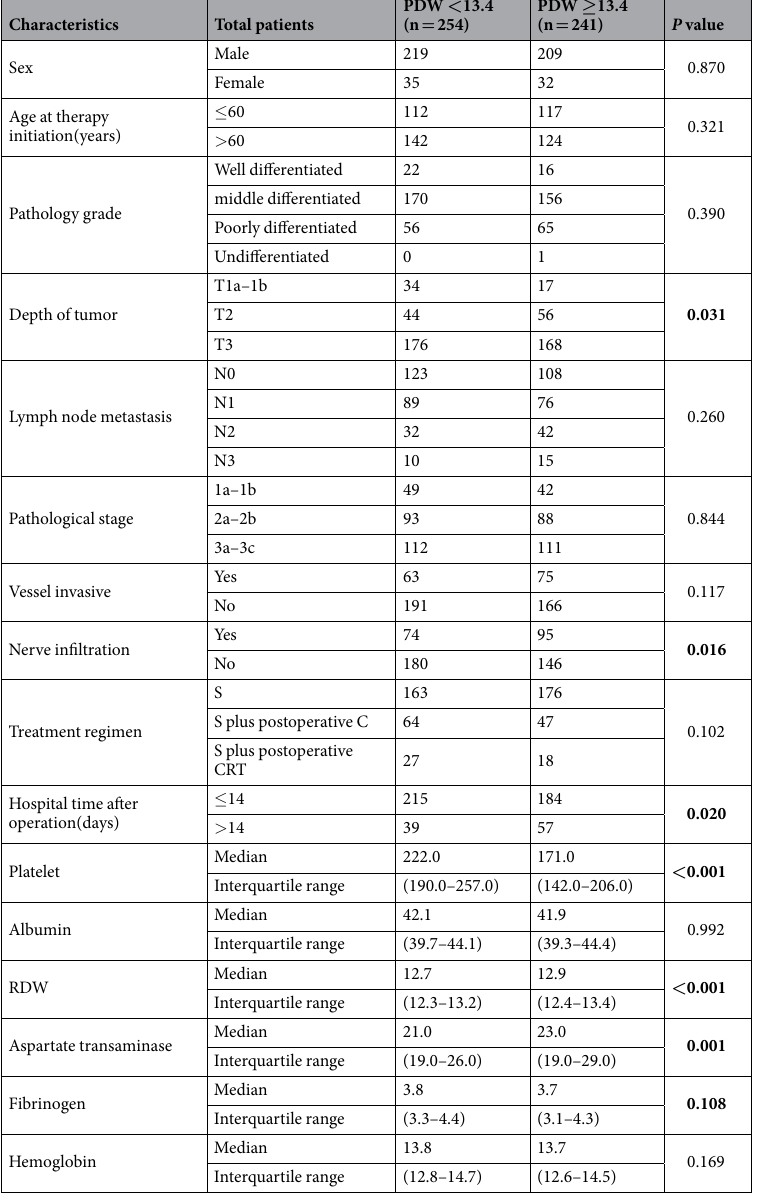
Table 2. Relationship between preoperative PDW and clinical-pathological features in patients with ESCC. Abbreviations: S, surgery; C, chemotherapy; CRT, chemoradiotherapy; PDW, platelet distribution width; RDW, red cell distribution width.